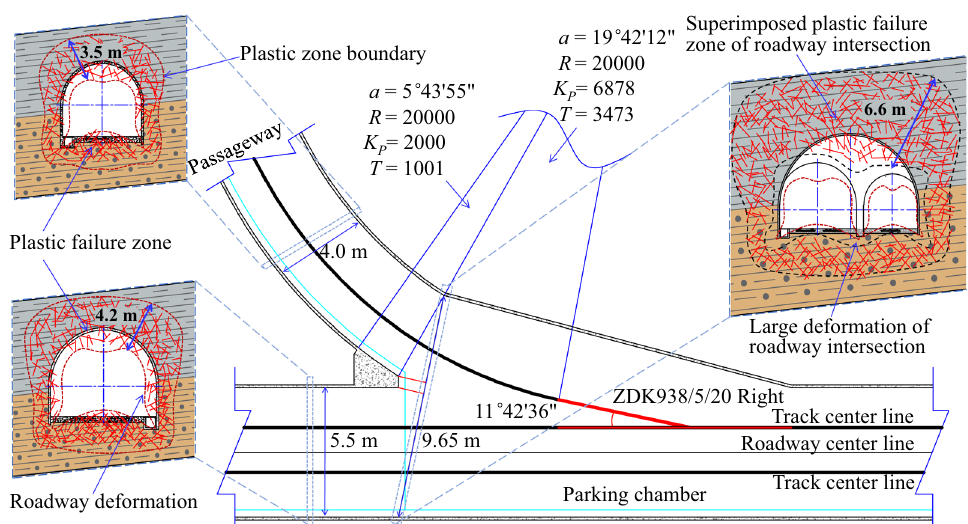
Fig. 4 Schematic of the plastic zone of each section at the No. 10